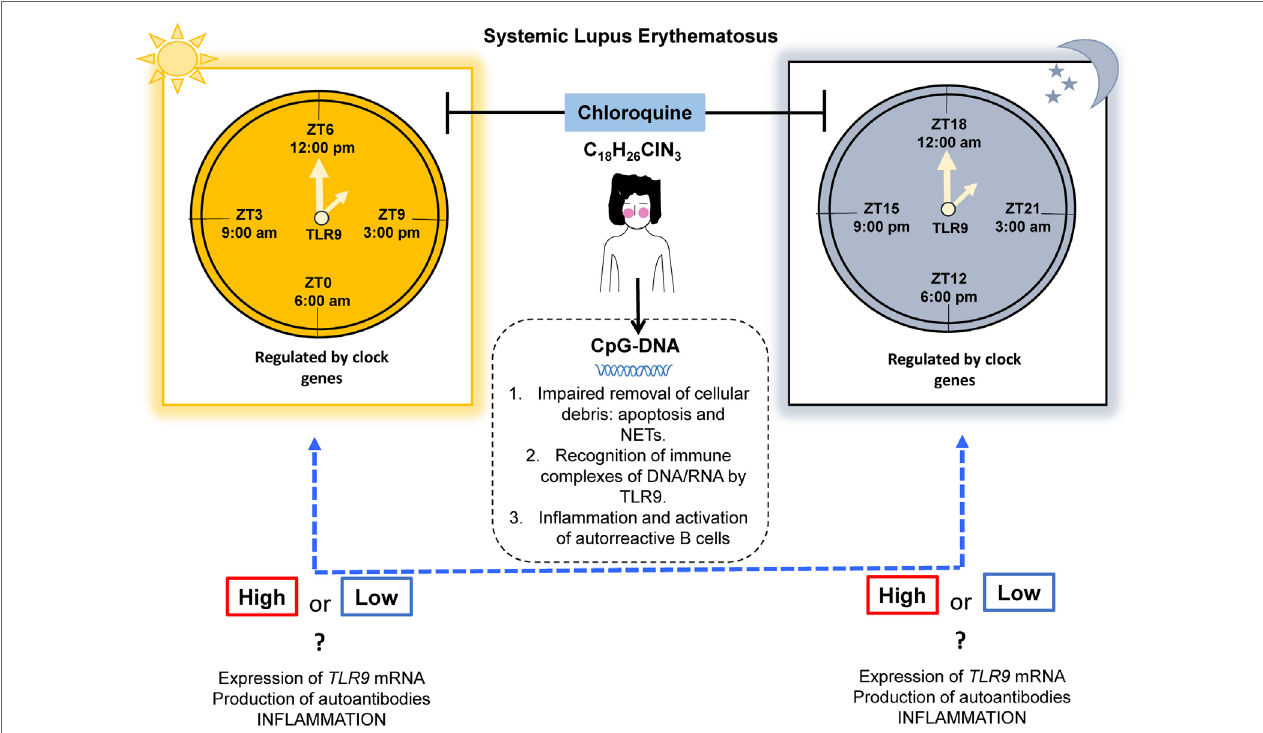
FiGUre 2 | Proposal for a chronotherapeutic effect in SLE patients receiving CQ treatment. Ligands for TLR9 include CpG-DNA, which might originate during impaired clearance of cellular debris. The expression of TLR9 has shown circadian behavior in mice, with higher expression at ZT19 (1:00 a.m.) and lower expression at ZT7 (1:00 p.m.) and this is regulated by clock genes. However, in humans, this information is lacking. CQ acts as an inhibitor of TLR9 by masking its binding sites for nucleic acids. We propose that the chronotherapeutic optimization of CQ would make it more beneficial if it is prescribed when there is maximal expression of TLR9 in SLE that possibly leads to a reduction in the expression of TLR9, autoantibodies production, and inflammation (dotted blue line). Abbreviations: CQ, chloroquine; SLE, systemic lupus erythematosus; ZT, Zeitgeber time; NETs, neutrophil extracellular traps; TLR9, toll-like receptor